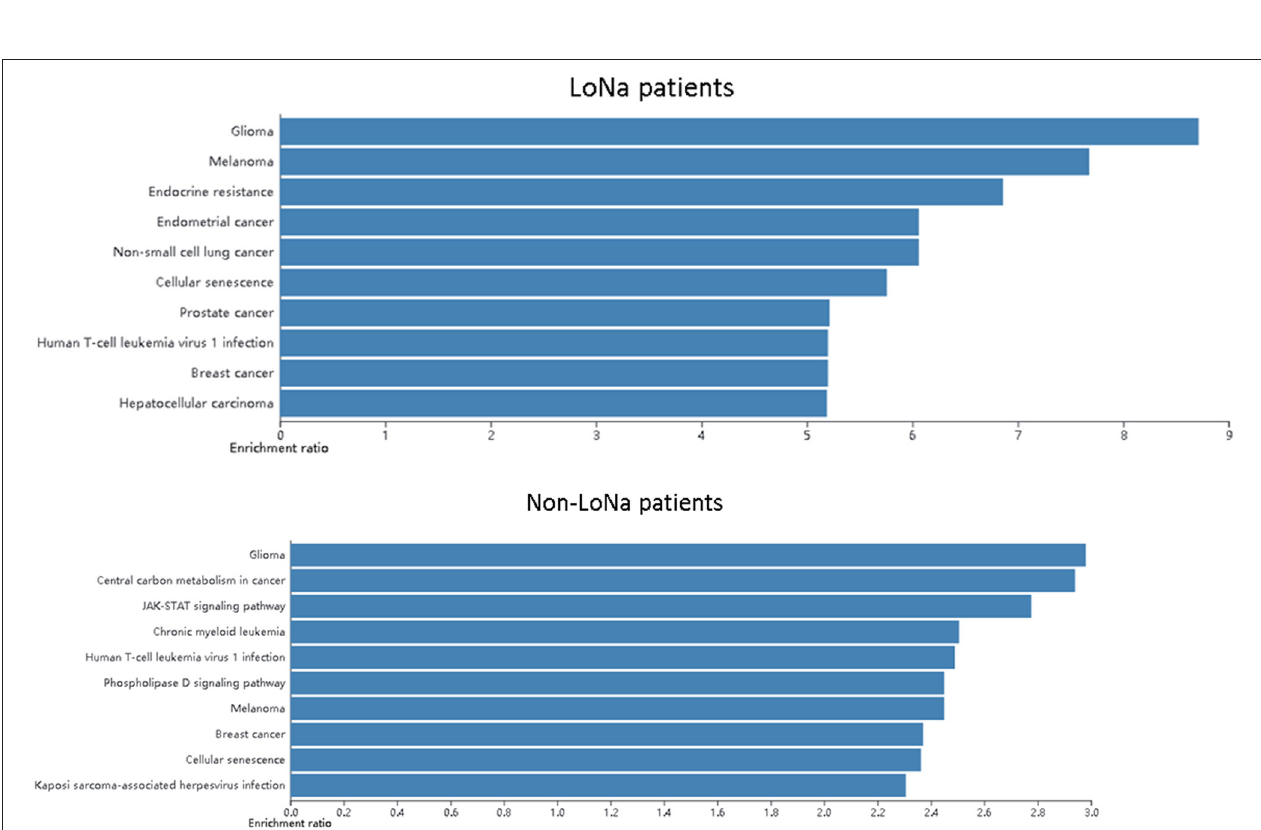
FIGURE 5 | Correlation of TMB in different types of pre-treatment sample.